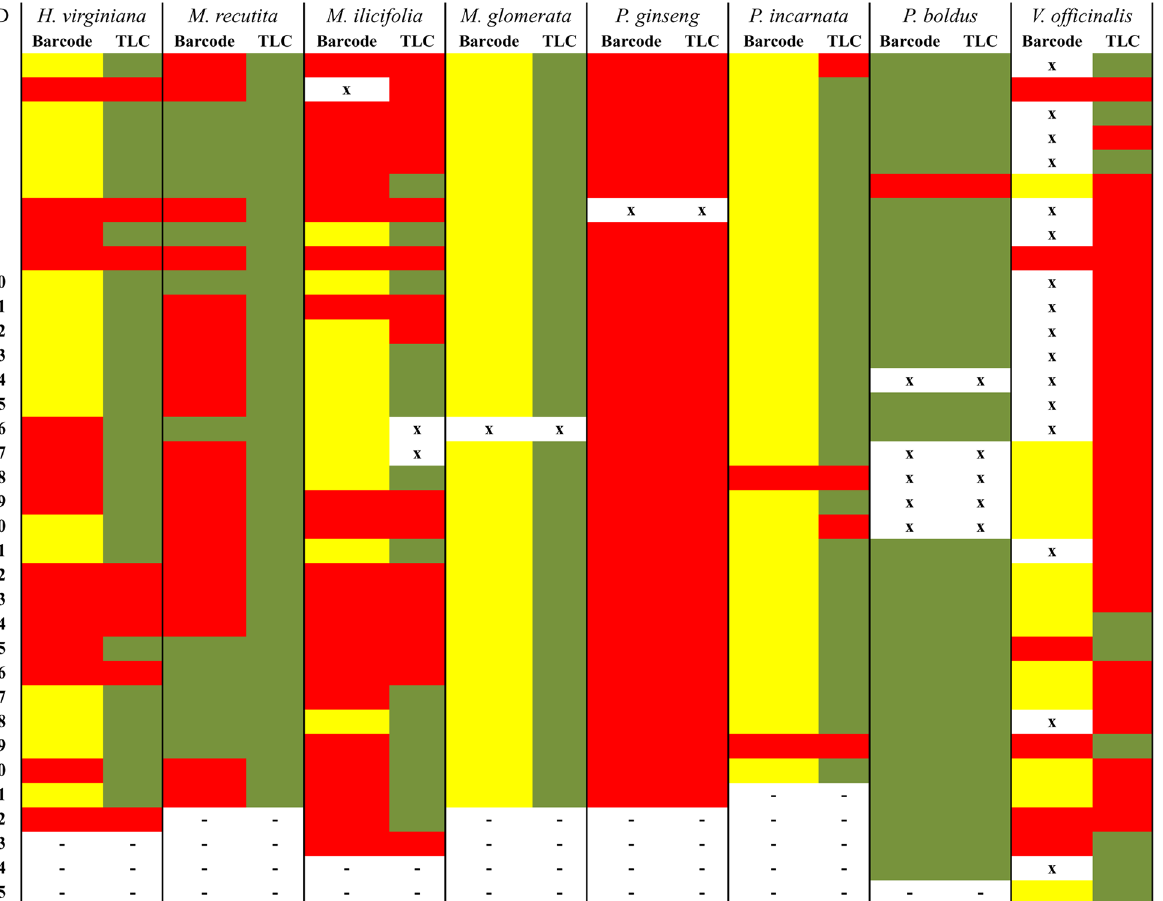
Fig 4. Comparison between the DNA barcode and TLC findings. ID: sample number. Green: samples that were identified as the expected medicinal species using DNA barcoding and that contained the expected chemical marker from the medicinal species according to TLC. Yellow: samples that were not identified within the genus of the medicinal species using DNA barcoding. Red: samples that were identified using DNA barcoding as a genus or family that varied from the expected one and that did not contain the chemical marker according to TLC. X: samples that did not generate any sequence using DNA barcoding or that could not be tested using TLC. -: absent